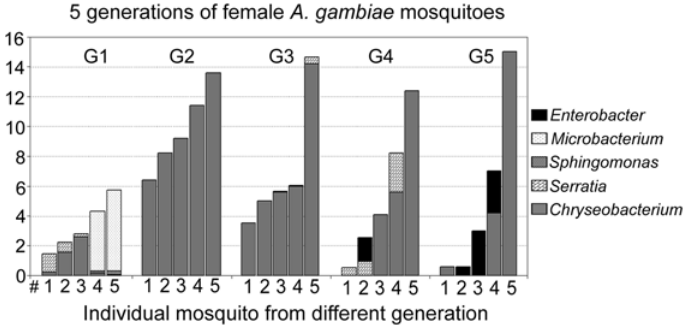
Figure 1. Distribution of bacterial loads and major species composition of midguts microbiota in 5 individual laboratory-reared 5-d- old female A.gambiae mosquitoes from 5 consecutive generations. The bacteria species were determined to be closely related to Enterobacter asburiae , Microbacterium sp., Sphingomonas sp., Serratia sp., and Chryseobacterium meningosepticum . G1 to G5 denotes generation 1 st to 5 th .